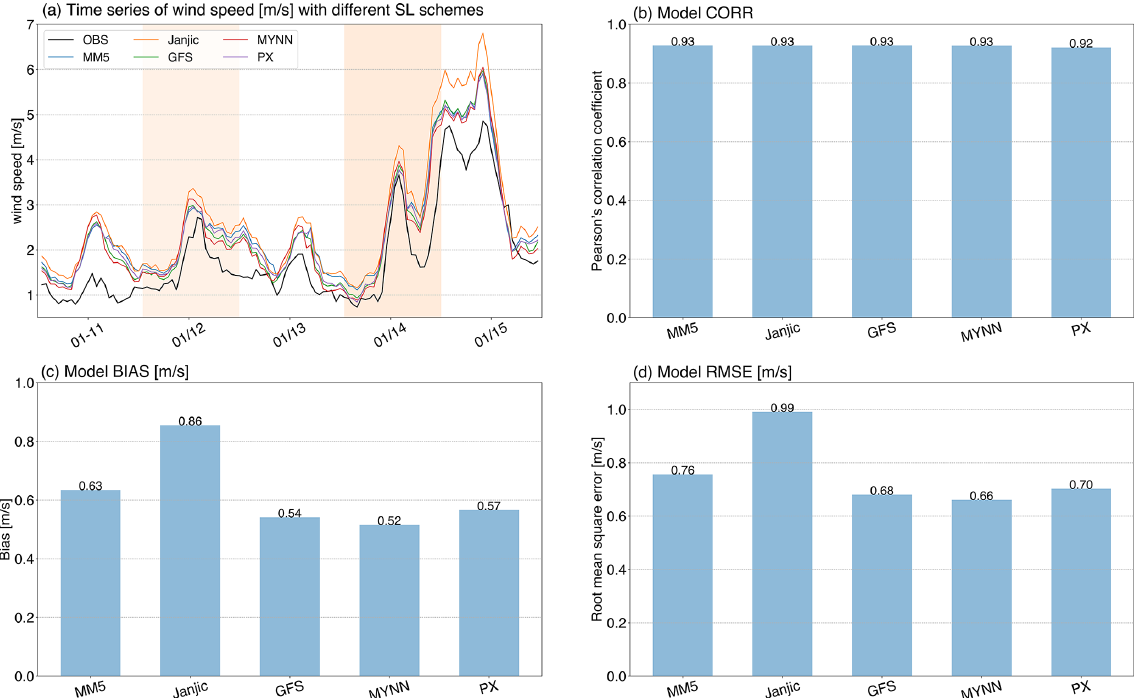
Figure 16. Same as Fig. 3 but for simulations with different surface layer